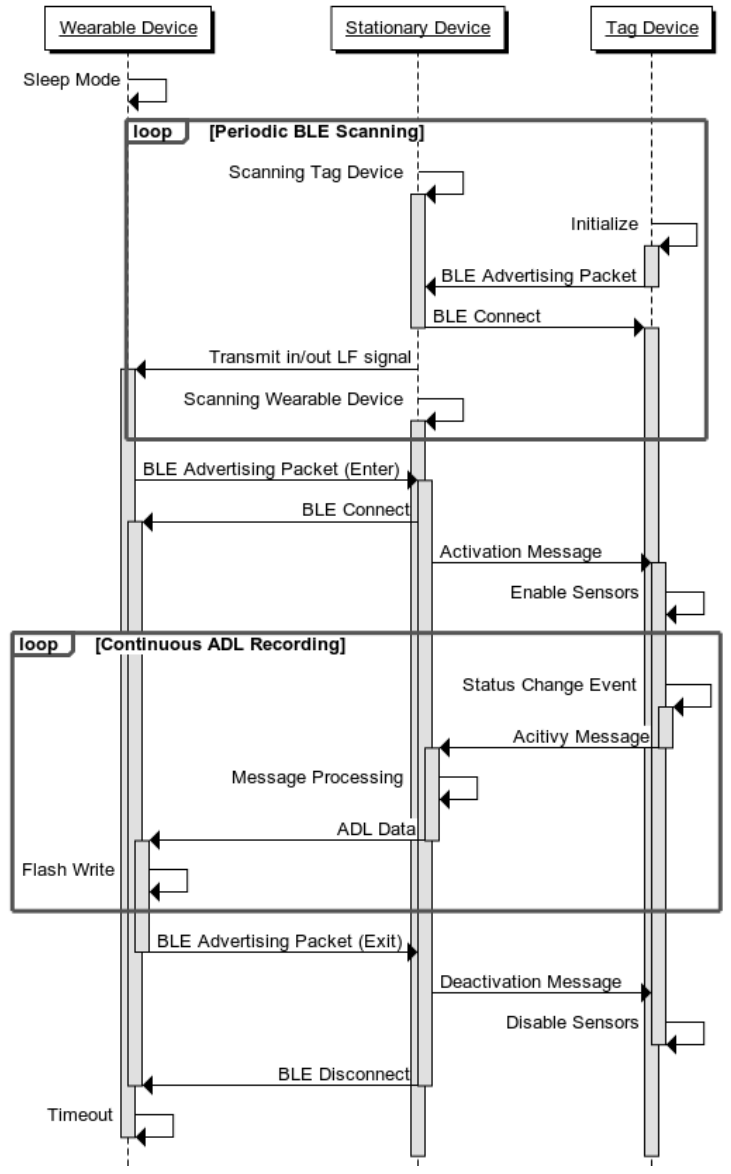
Figure 2. Communication sequence of self-organized device network structure.